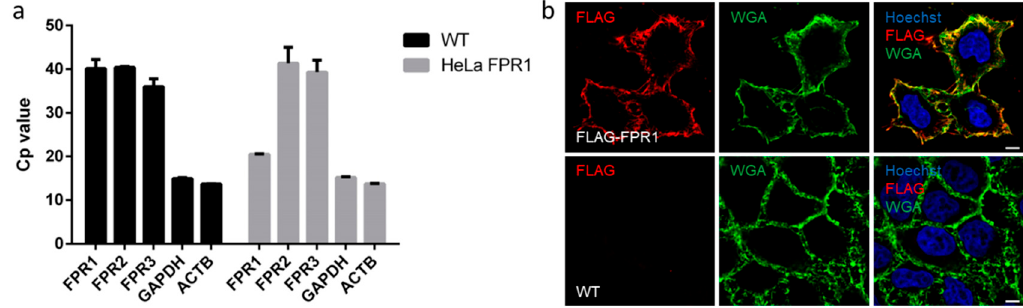
Figure 1. Evaluation of FPR1 (formyl peptide receptor 1) expression and localization in the heterologous HeLa expression system. ( a ) qRT-PCR revealed that none of the three FPR paralogs is expressed in parental HeLa cells (WT), whereas FPR1 is readily detectable in the HeLa-FPR1 transgenic cell line. Housekeeping genes ACTB (beta actin) and GAPDH (glyceraldehyde 3-phosphate dehydrogenase) served as internal controls. ( b ) Confocal immunofluorescence microscopy with the M1 antibody (red channel) confirmed the plasma membrane localization of FLAG-tagged FPR1. The plasma membrane was stained with WGA (green channel), and nuclei were visualized using Hoechst stain (blue channel). Upper panel: HeLa-FPR1 cell line; lower panel: WT HeLa cells, scale bar, 5 µ m.